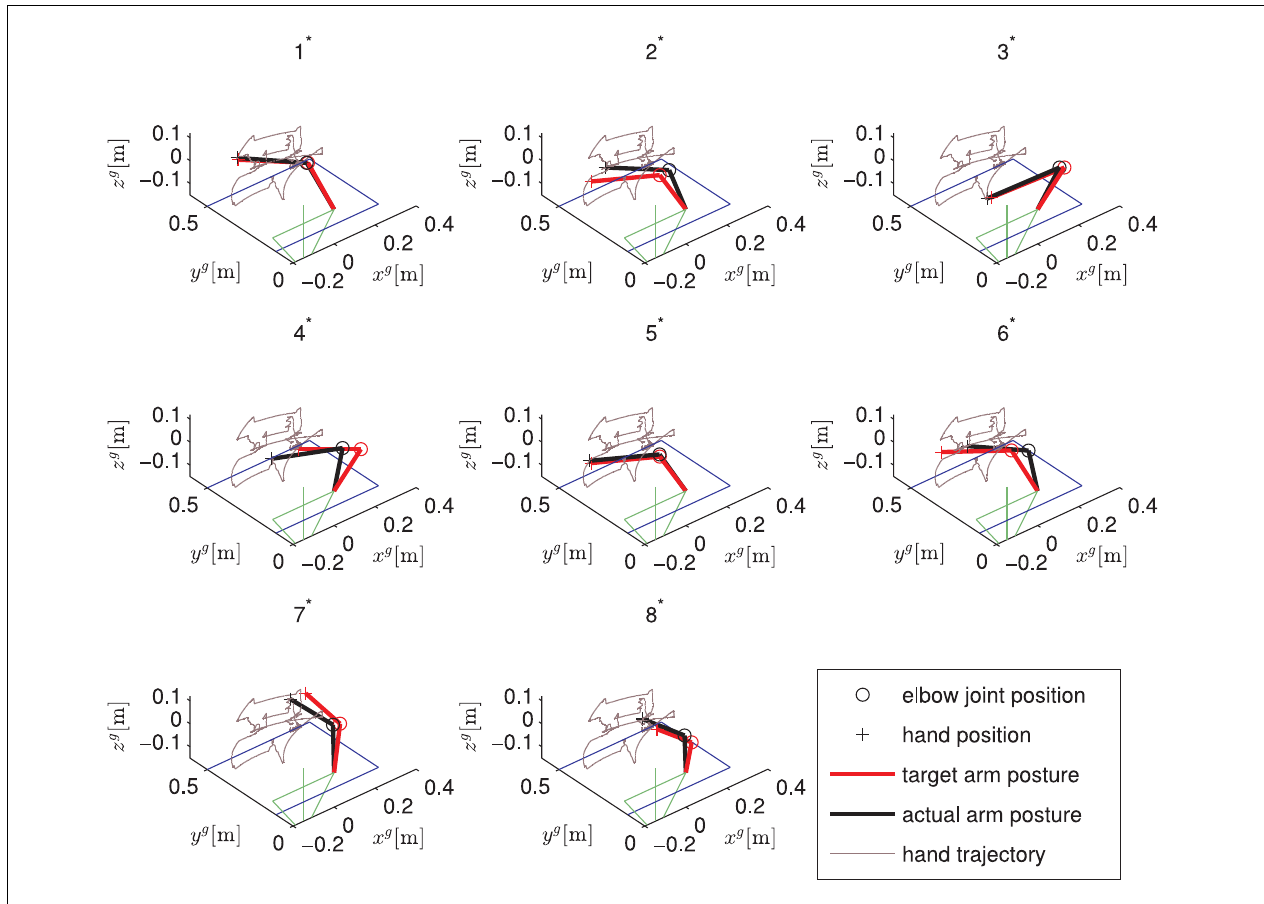
FIGURE 10 | Static arm postures for one trial of the described drinking task. Shown are the desired arm postures and the actually obtained ones for the endings of the eight arm movements defined